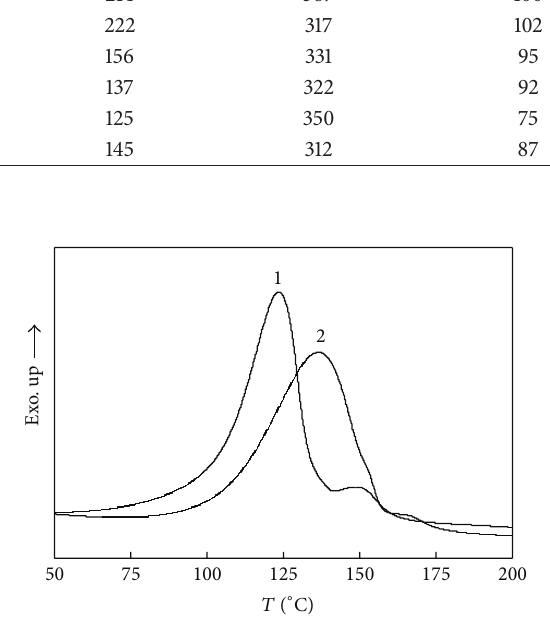
Figure 2: DSC curves of curing reaction of IMTHPA-cured ED-20 resin in the presence of catalysts: (1) 1-methylimidazole; (2) 1-butyl- 3-methylimidazolium